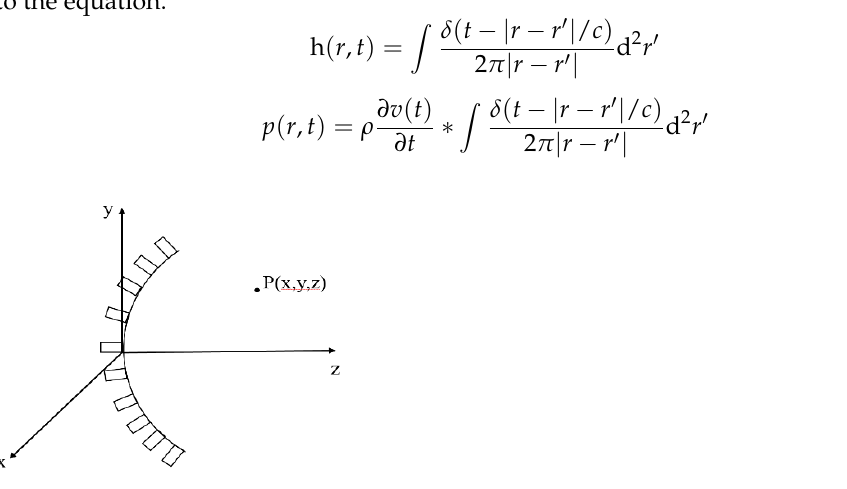
Figure 7. Sound field calculation model of R-zone of stringer.